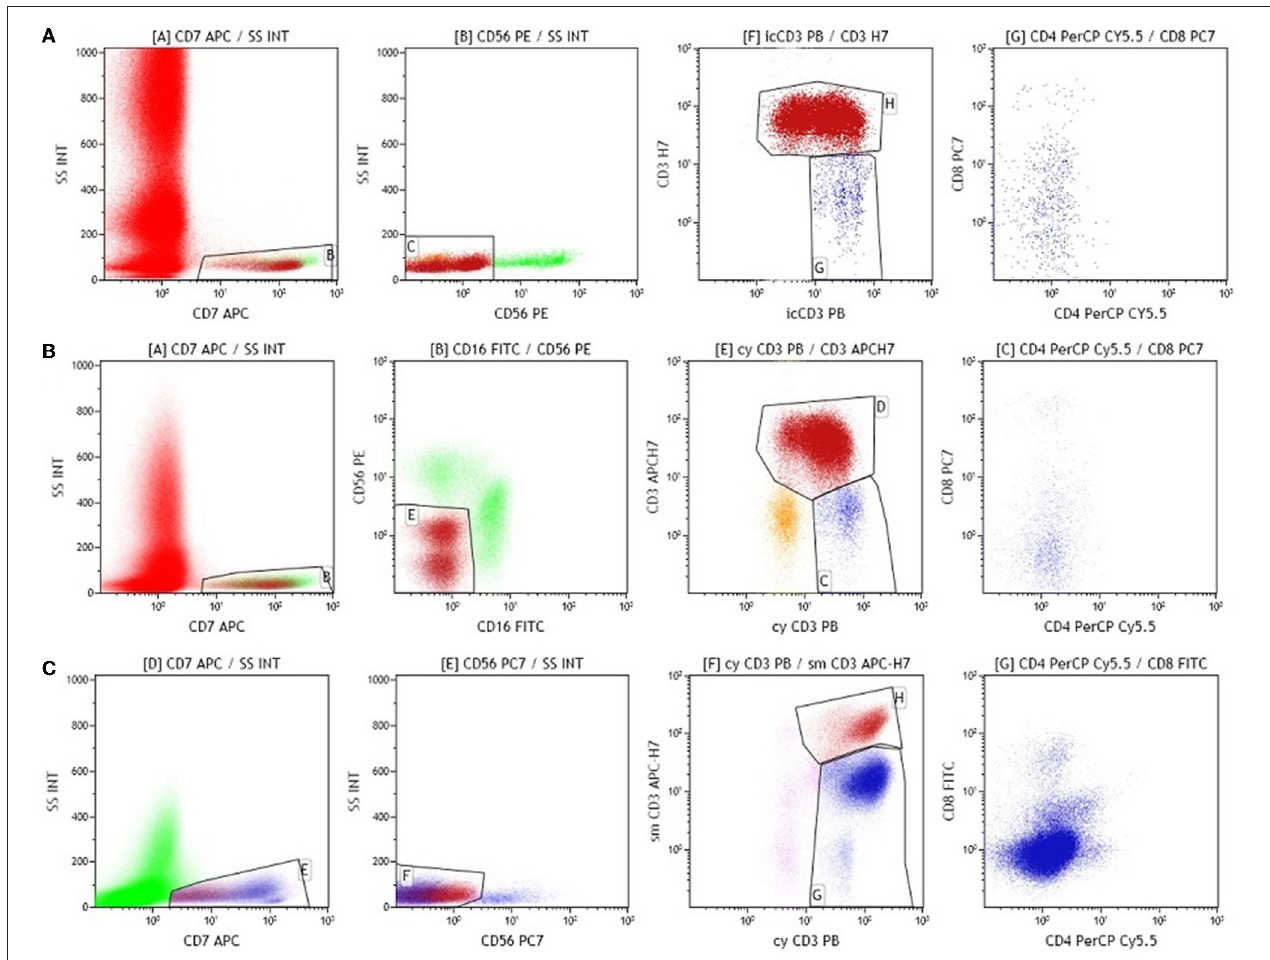
FIGURE 3 | Immunophenotyping performed on bone marrow (A–C)